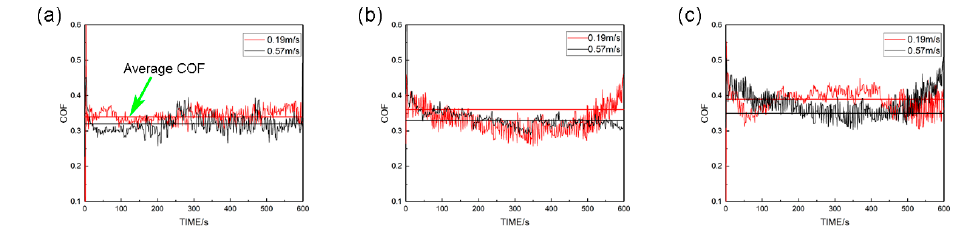
Figure 8. The Coefficient of Friction (COF) of alloys at sliding velocity of 0.19 m/s.